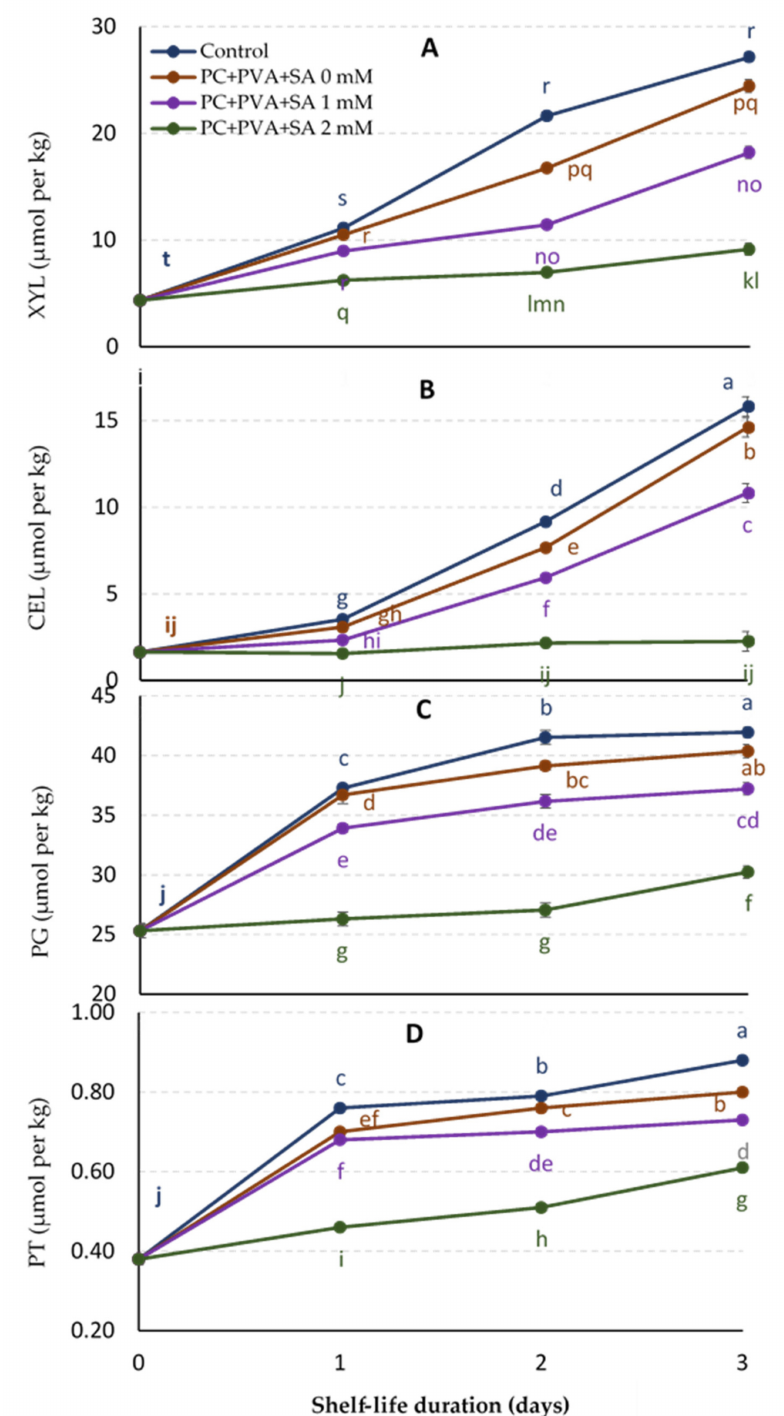
Figure 6. ( A ) cell wall degradation enzyme activities: xylanase (XYL), ( B ) cellulase (CEL), ( C ) polygalacturonase (PG), ( D ) and pectinase (PT) of ‘Crimson seedless’ grapes coated with PE + PVA blending with SA at different concentrations (0, 1, and 2 mmol L − 1 ) and stored at room tem- perature (26 ± 1 ◦ C and 65 ± 5% RH) for 3 d. Each value represents a mean of three replicates, with error bars representing standard errors ( ± SE), and different letters indicate significant differences at p ≤ 0.05 between treatments. Mean comparisons were performed between all